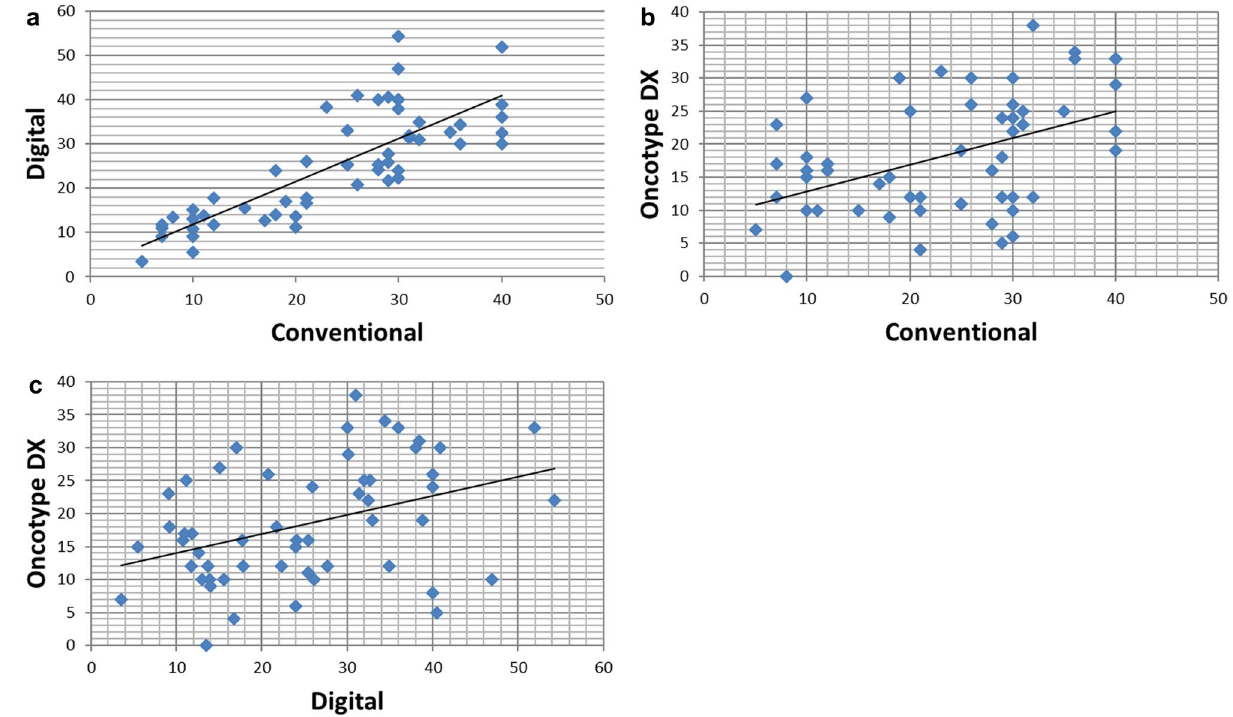
Figure 1. Dispersion of Ki67 quantification by conventional and digital methods showing a strong and linear positive correlation ( A ), and dispersion of the Oncotype DX Recurrence Score with Ki67 quantification by conventional ( B ) and digital ( C ) evaluation, showing a moderate and linear positive